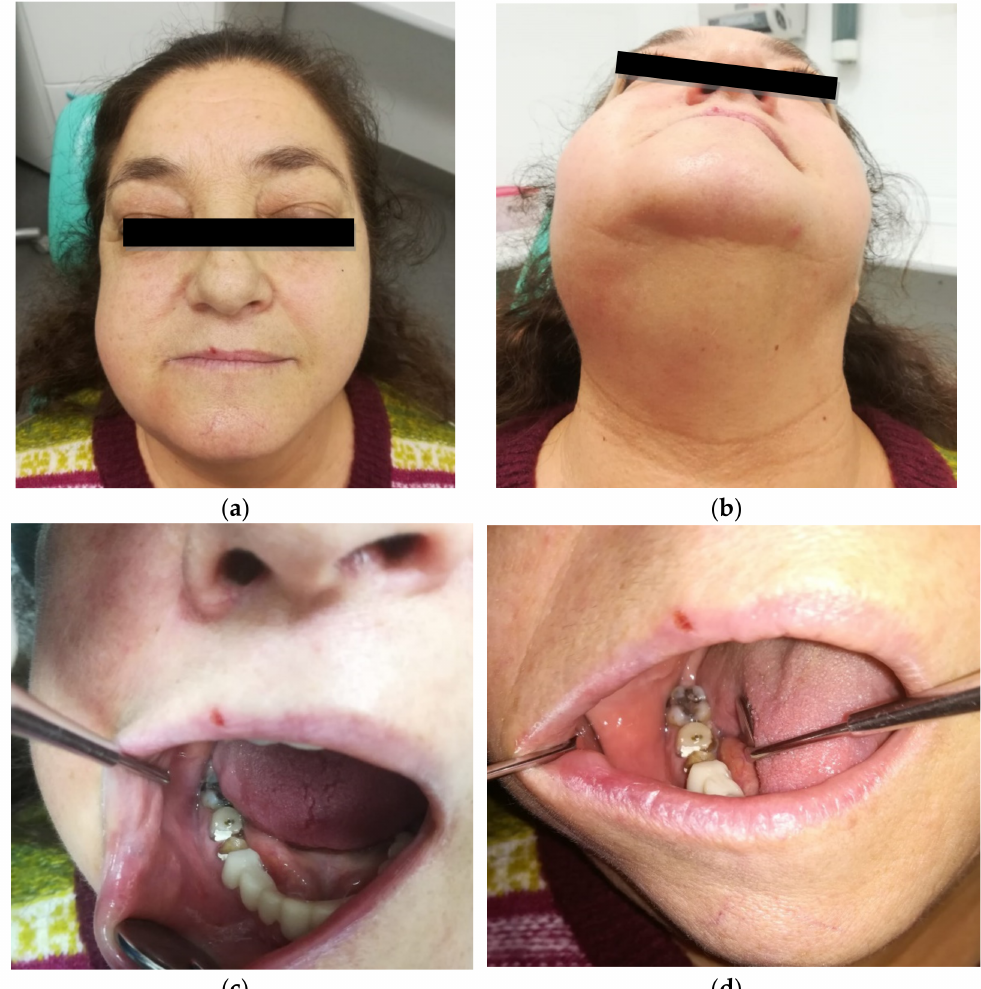
Figure 1. ( a , b ) Extraoral examination. An area of swelling on the right side of the cervicofacial region is clearly visible. ( c , d ) Intraoral examination. The right fornix and oral floor appear